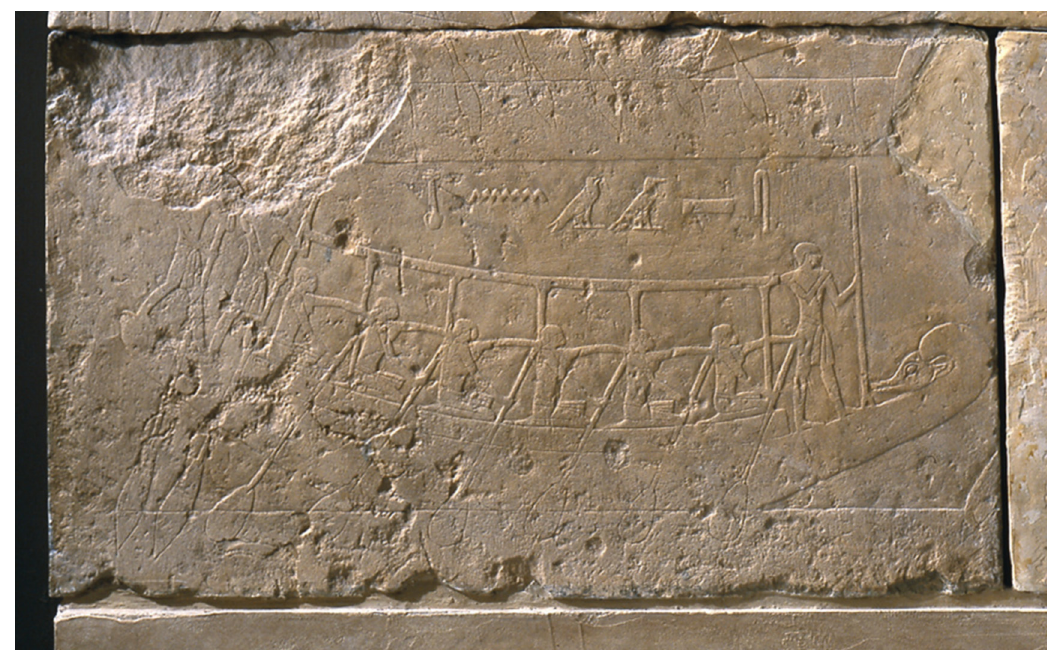
Figure 7. Detail of a hedgehog-head boat being rowed on the south wall of the 5th Dynasty tomb of Raemka, Saqqara, now in the Metropolitan Museum of Art (MMA 08.201.1g). The hieroglyphic